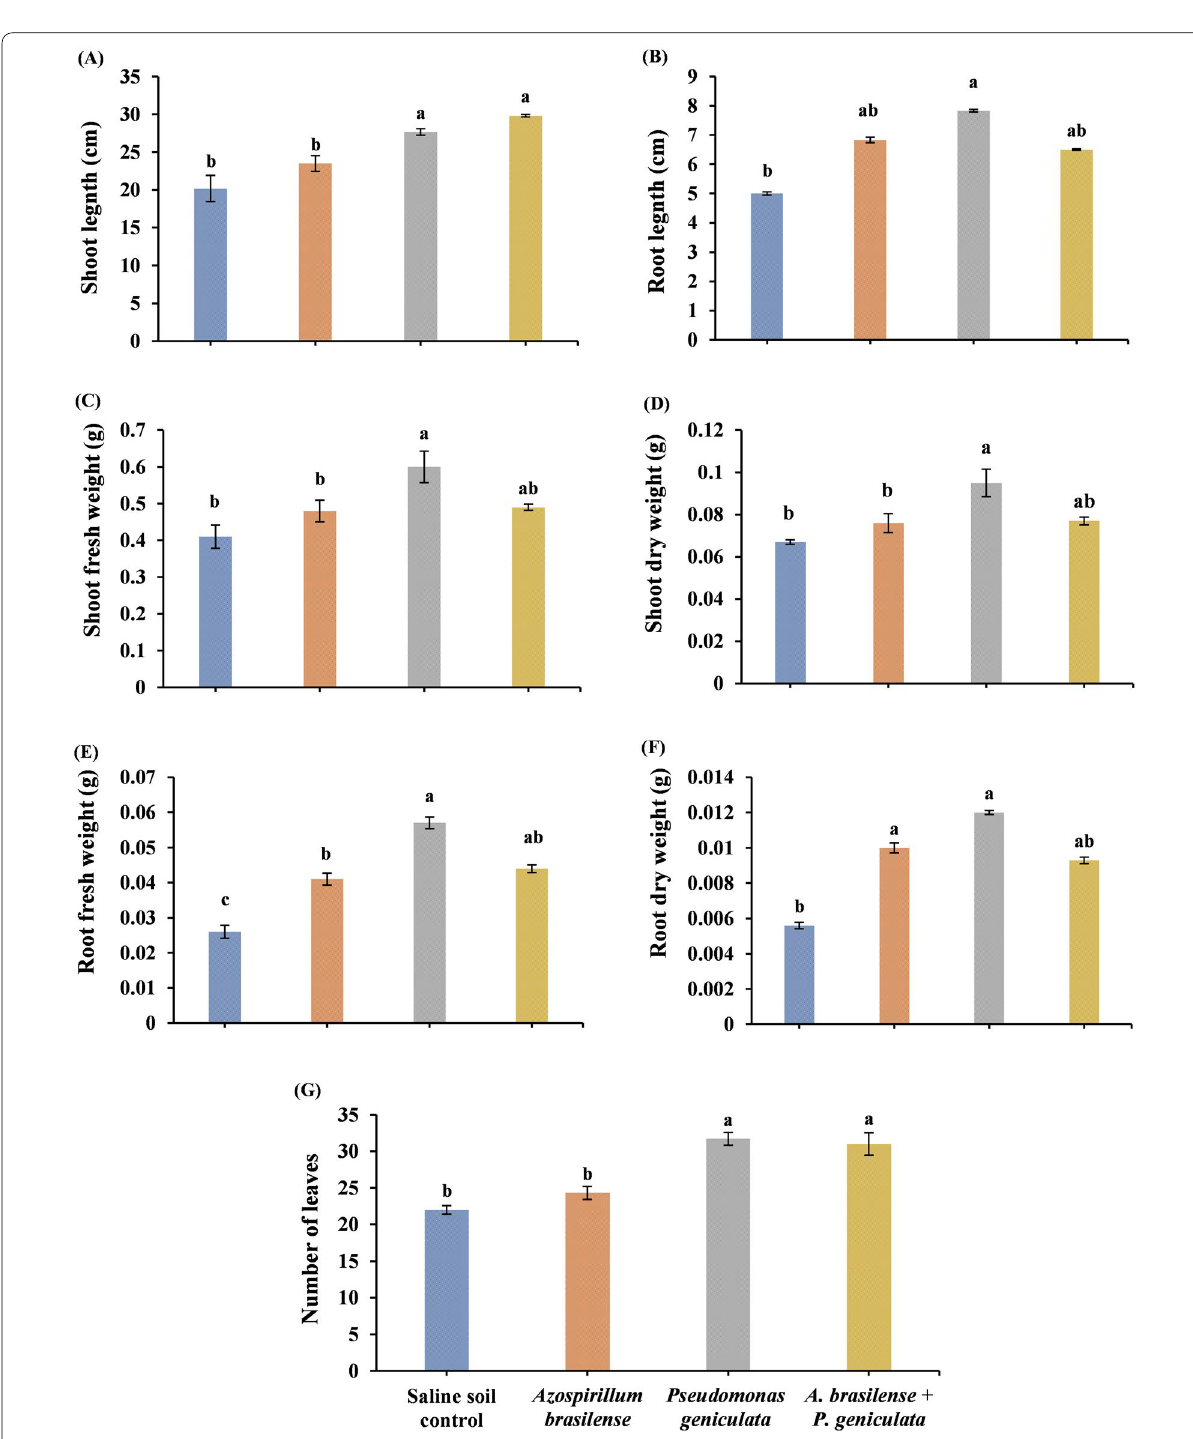
Fig. 1 Effect of the inoculation with Azospirillum brasilense , Pseudomonas geniculata individually or co-inoculation on growth parameters ( A ) shoot length; ( B ) root length; ( C ) shoot fresh weight; ( D ) shoot dry weight; ( E ) root fresh weight; ( F ) root dry weight; and ( G ) number of leaves of flax plants ( Linum usitatissimum ) grown in saline soil. Bars represent the mean of three replicates (n indicate significant difference among means according to LSD test at p <